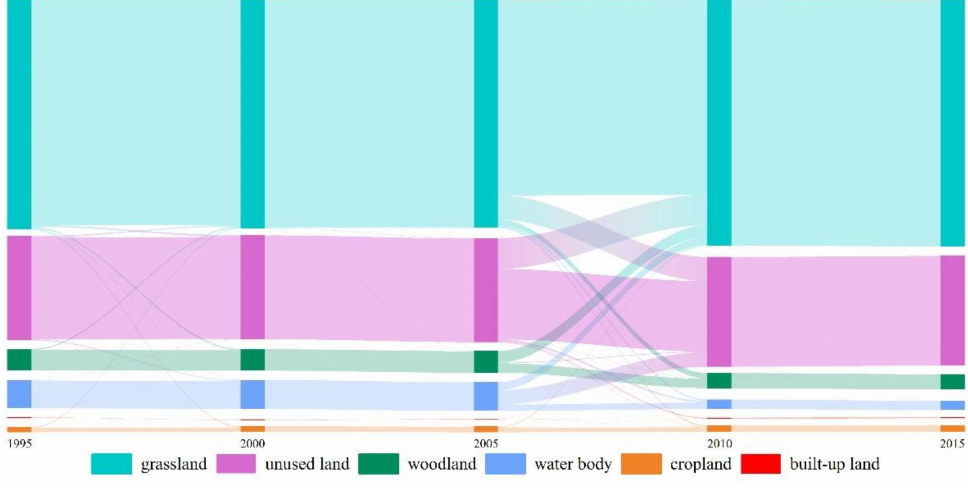
Figure 4. Land-use transitions from 1995 to 2015.